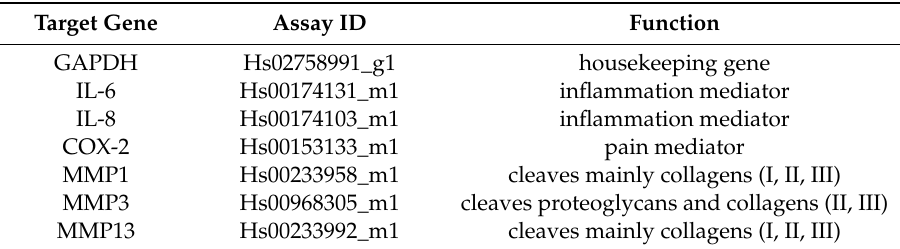
Table 1. Target genes and primer Assay ID numbers used in this